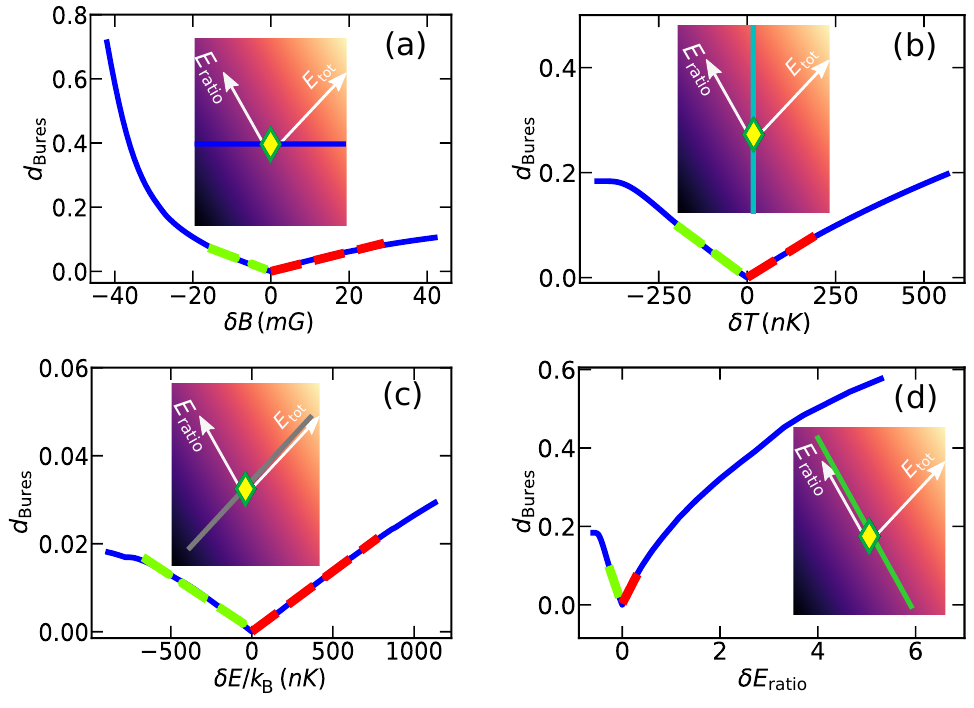
Figure 4: Bures distances. For constant temperature T = 435nK (a), a constant = 0.6 (c) and for a magnetic field B = 43mG (b), a constant energy ratio E ratio / k = 1.6 (cid:181) K (d). The reference state at T = 435nK and constant total energy E tot B B = 43mG is marked by the diamond as in Fig. 2. The dashed lines represent the Taylor expansion to the first